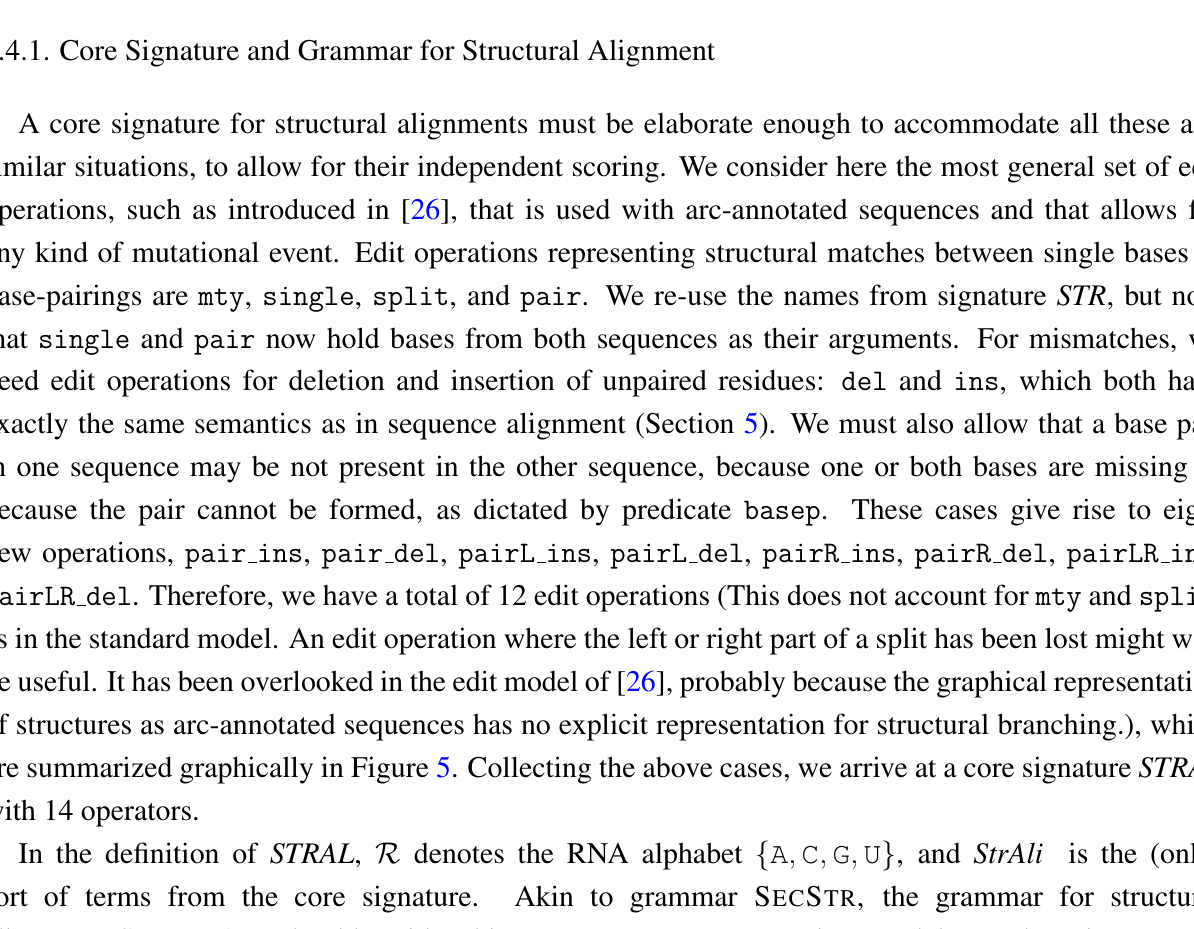
Figure 7. Example of a structural RNA alignment. Vertical bars indicate matching bases in the sequences. Note that the two structures are different, but